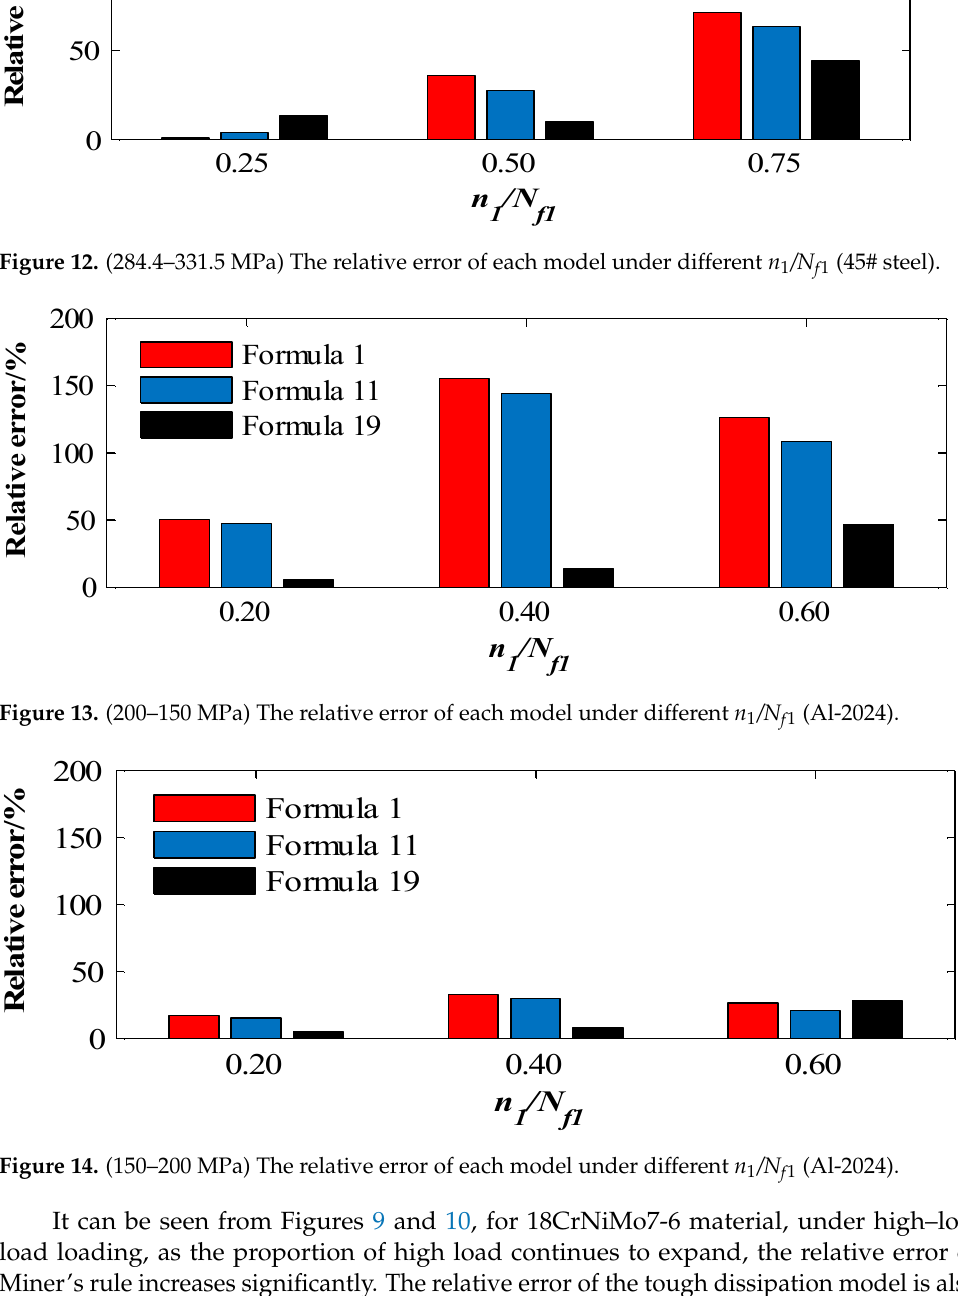
low loading, as the proportion of high load continues to increase, the relative error value Figure 11. (331.5–284.4 MPa) The relative error of each model under different n 1 /N f 1 (45# steel). is higher than under low–high loading, and the proportion of low load continues to in- crease. Table 6. Al-2024 aluminum alloy two-stage loading test data and remaining life prediction results of each model . Two-Stage